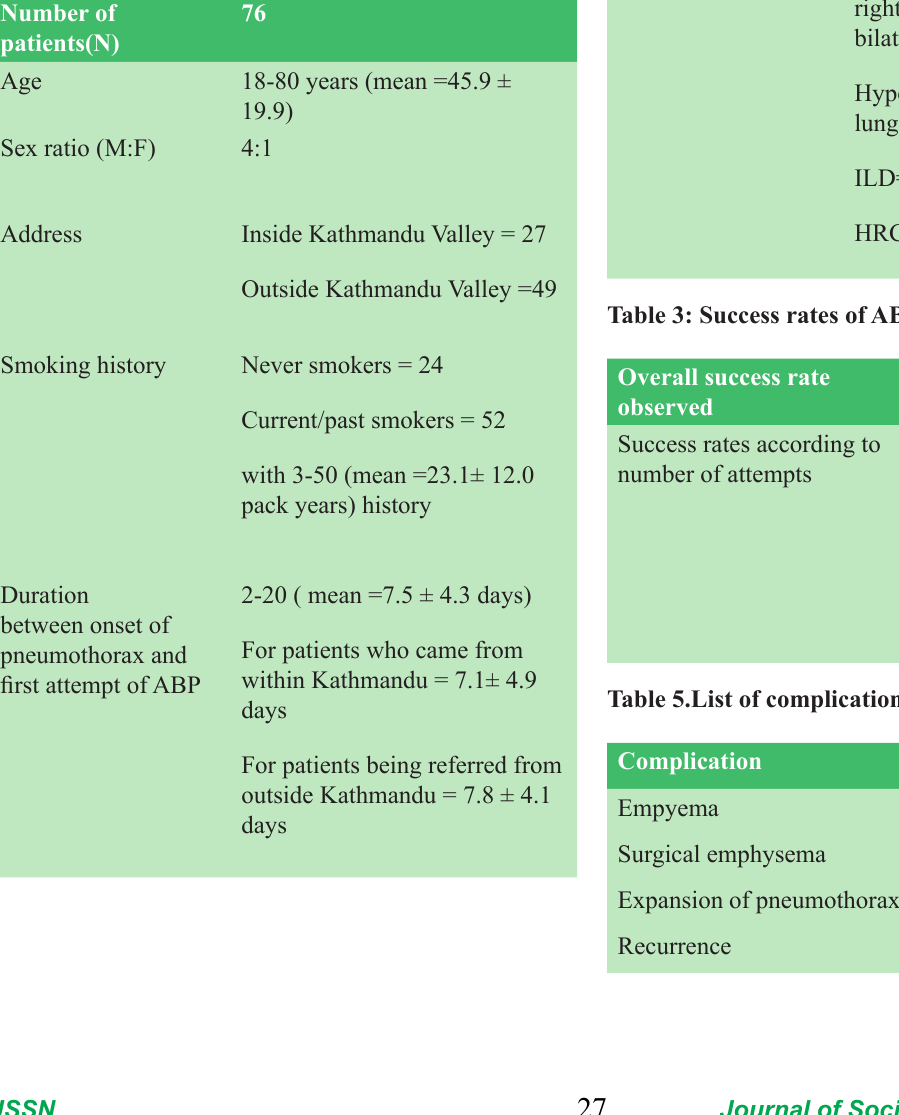
Table 1.Demographic data of patients.